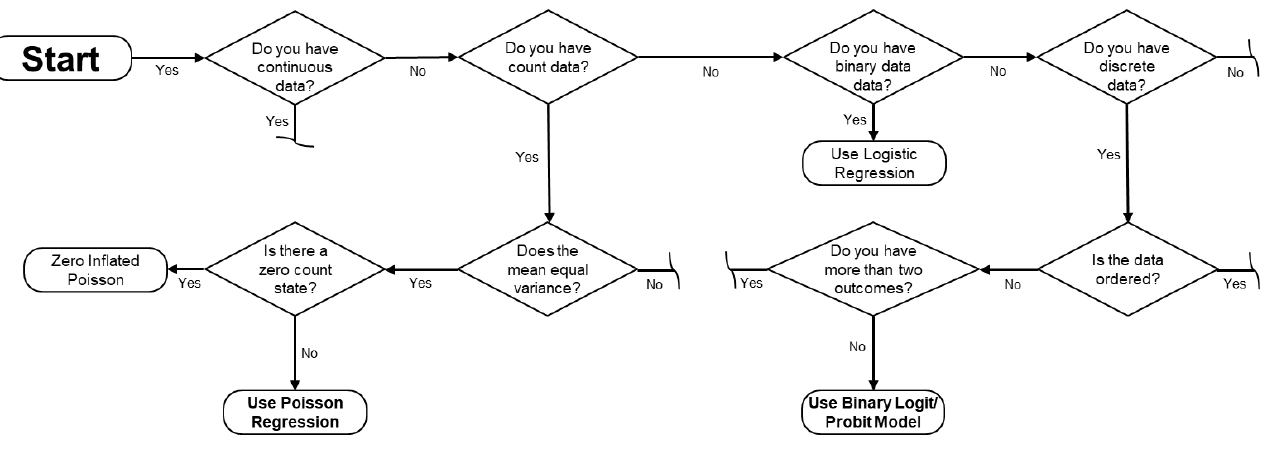
Figure 2. Model screening guide.